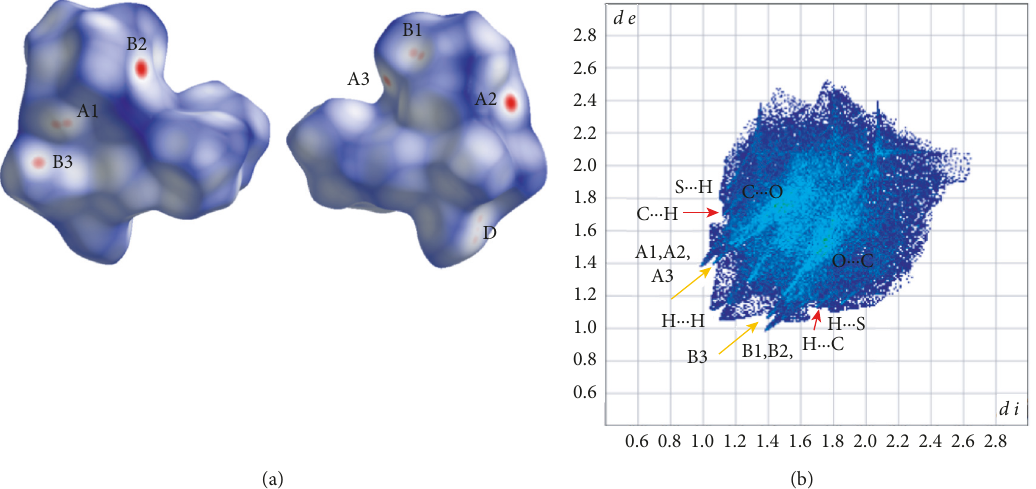
Figure 8: (a), Different views of the d and acceptor contact points of C 9 —H 9 (A) hydrogen bond interactions (Table 5). Label D indicates the area of antiparallel CO fingerprint plot indicate the C